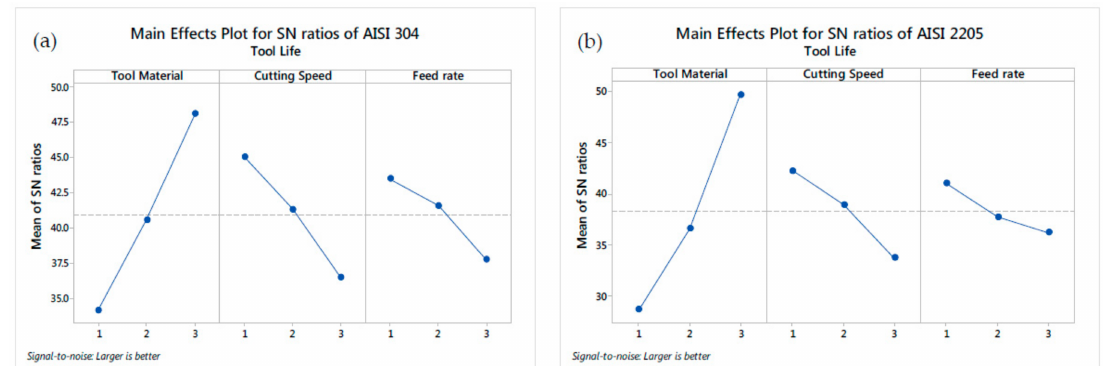
Figure 2. Mean signal to noise (S/N) ratio graph for tool life of ( a ) AISI 304 and ( b ) AISI 2205